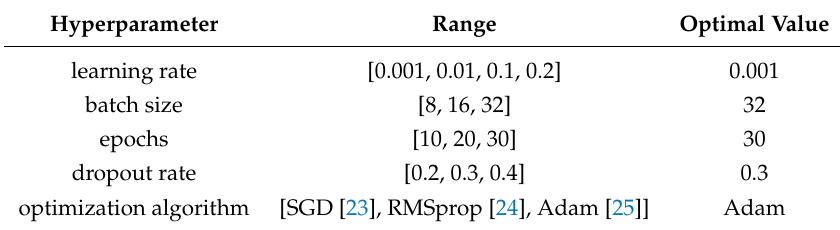
Table 1. The range and optimal values of hyperparameters for